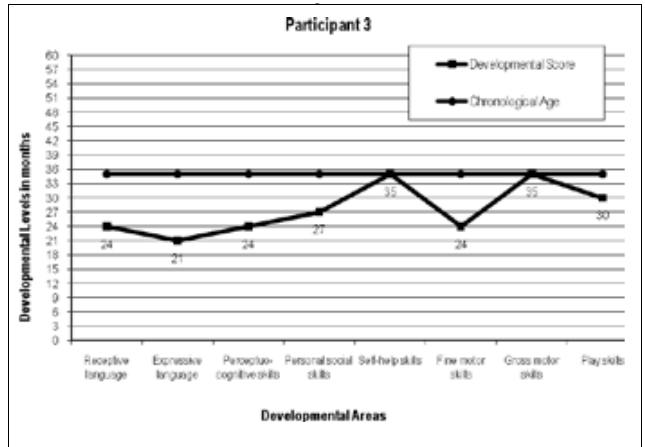
Fig. 3. Participant 3: Comparison between chronological age and participant’s level of developmental functioning.